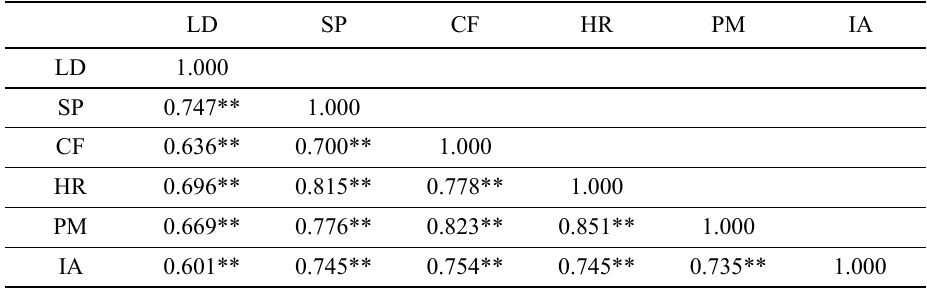
Table 4. Correlation analysis: relationship between independent variables LD SP CF